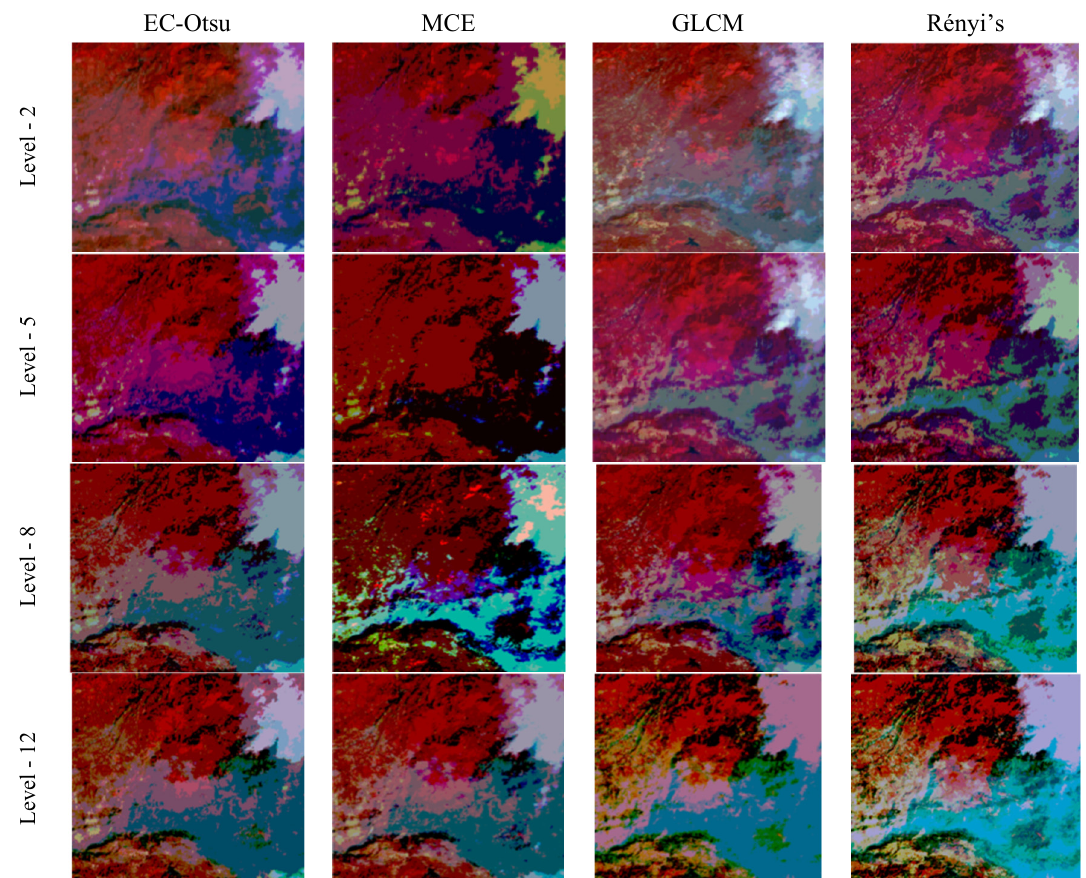
Figure 23. EC-Otsu, MCE, GLCM, and Rényi’s entropy function-based segmented images using Modified-CS for thresholding levels 2, 5, 8, and 12. Table 12. Statistical analysis (Wilcoxon rank sum test) of 20 runs for each of the 20 independent samples for the experi- ments.